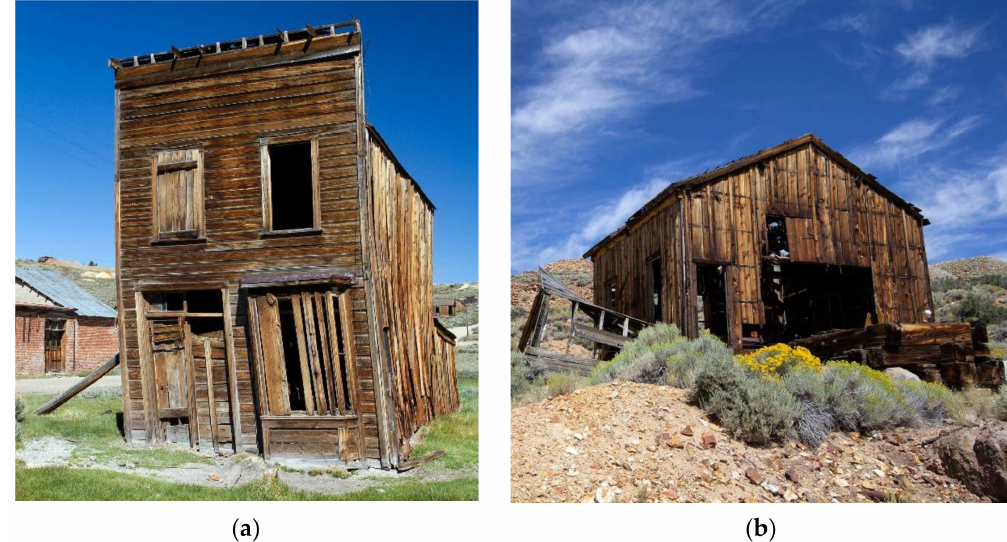
Figure 3. Examples of “arrested decay” at Bodie. ( a ) Swazey Hotel; ( b ) New Standard Hoist building. Photographs ( a , b ) by N.